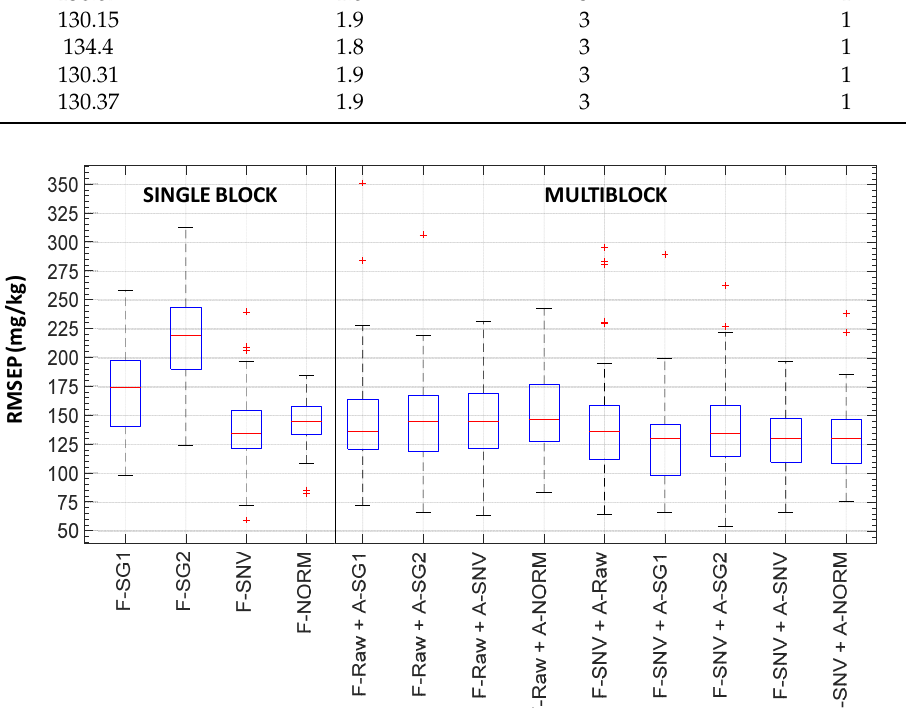
Figure 6. LV boxplot raw data of 50 iterations of the double cross-validation: on the left for PLSR model with fluorescence raw data; on the right for multiblock SO-PLS model with fluorescence and absorbance raw data. Bottom and top edges of the blue box are the 25th and 75th percentiles, re- spectively; the central mark is the median; whiskers extend to the most extreme data points not considered outliers; the ‘+’ symbol plots outliers. The PLSR model on the single block of fluorescence raw spectra (F-RAW) achieved moderate performance in terms of RMSEP, with 177.11 mg·kg − 1 as the median value. The complexity of the model was high as the median value of LVs was eight. The combination of fluorescence and absorbance raw data provided better perfor- mance as the RMSEP median decreased to 134.45 mg·kg − 1 . Moreover, the complexity of the model was greatly reduced, which contributed to an increase in robustness. Three LVs was the median value for fluorescence data and only one LV was obtained for absorbance data instead of eight LVs when only raw fluorescence data were considered (Figure 6 and Table 3).